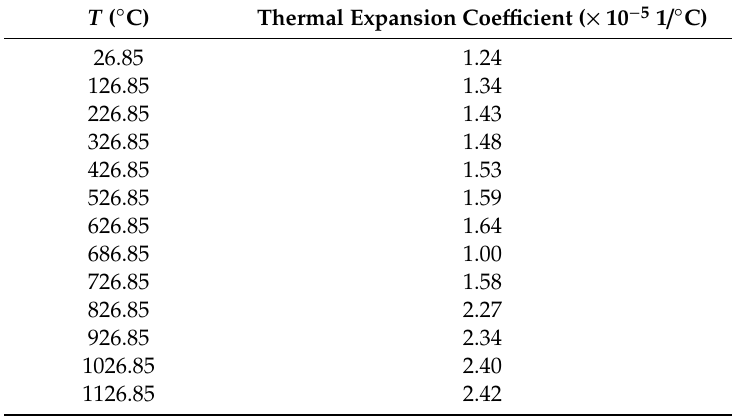
Table A4. Thermal expansion coe ffi cient for 42CrMo4 material measured on one substrate